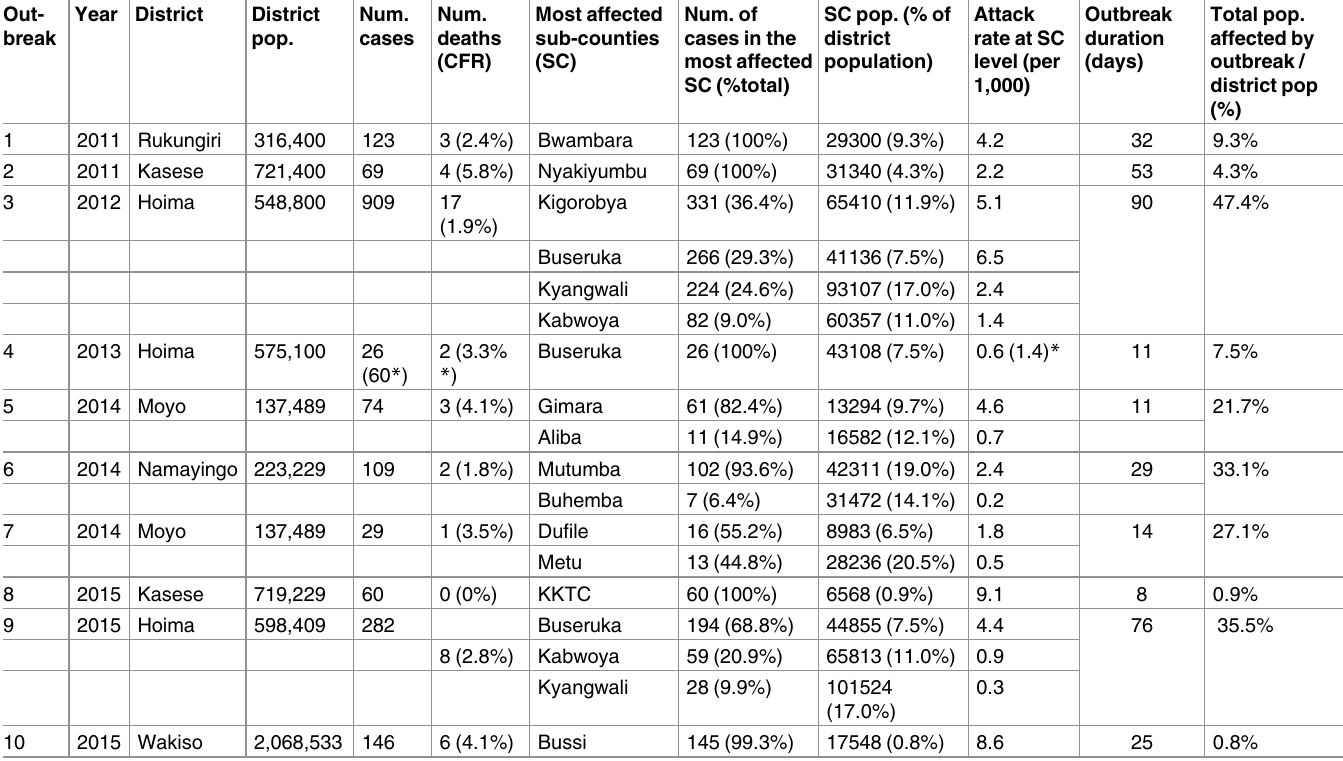
Table 1. Description of cholera outbreaks in fishing villages in Uganda, 2011–2015. Out- Year District District break